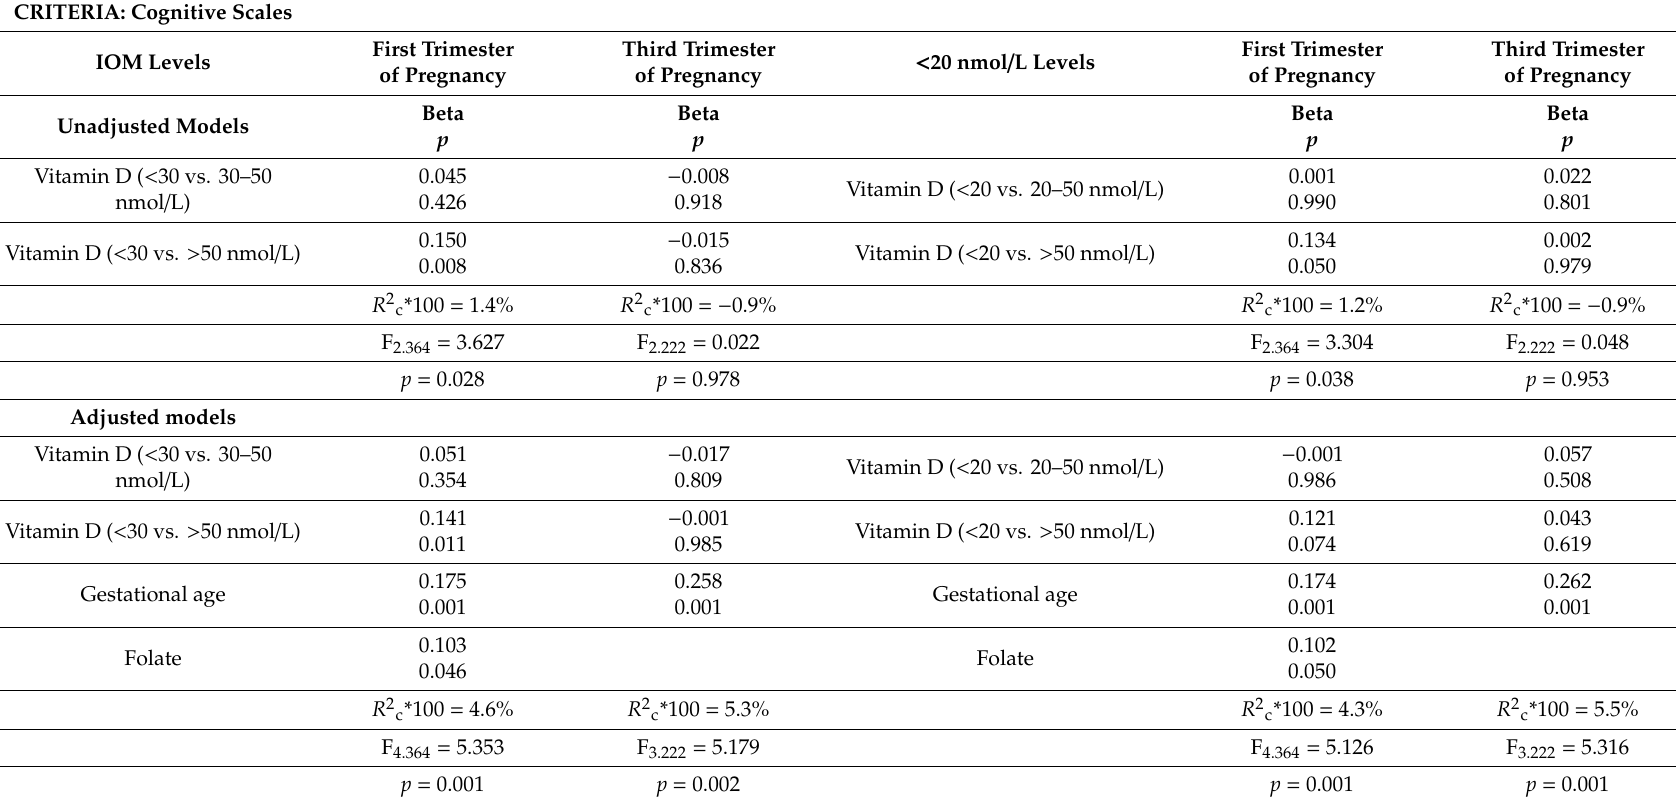
Table 4. Multiple linear regression models to explore the relationship between vitamin D during pregnancy (first and third trimesters) and the Bayle Scales of Infant Development-III (BSID-III) cognitive scale scores at 40 days